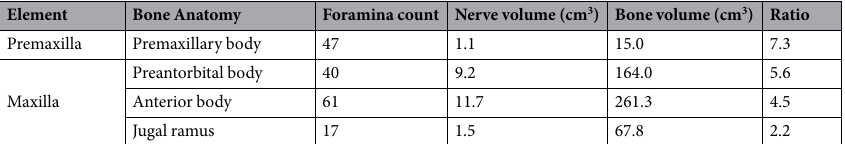
premaxillary branch of its medial nasal ramus (Fig. 1) 24 . This is the smallest of the three divisions and has a purely sensory function 32 . The maxillary (CN V 2 ) branch occupies the maxilla, relaying information from the upper jaw and teeth (Fig. 2) 9, 32 . Our identification of this structure in Neovenator as the ophthalmic and maxillary branches of the trigeminal nerve is consistent with its termination at numerous neurovascular foramina that pepper the bones of the skull (Figs 1A and 2A) 9, 12, 13 .